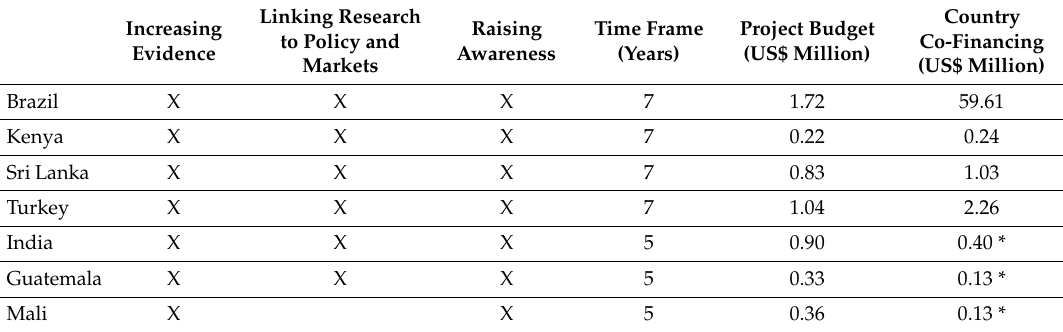
Table 1. The table indicates the project timeframes and level of investment used by countries to implement the three-pronged approach to mainstream biodiversity for food and nutrition. Linking Research Increasing Raising to Policy and Evidence Markets